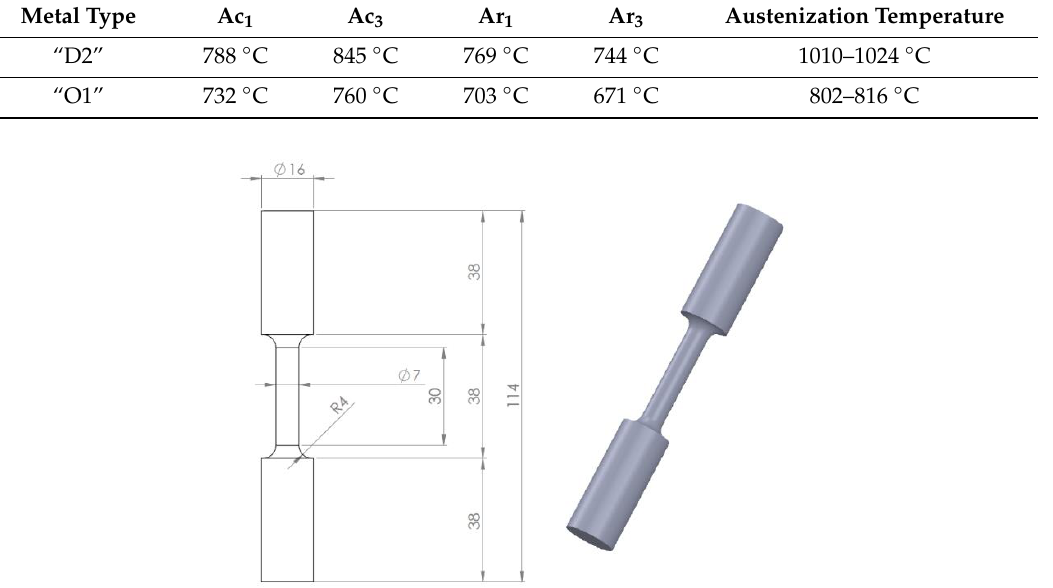
Figure 1. Tensile test specimen shape and geometry in mm.